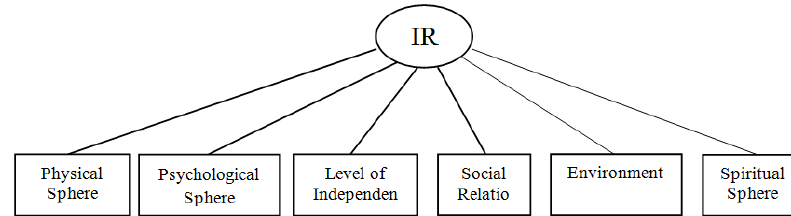
Figure 5. Correlation relationships of the indicator “IR” of the teachers’ group 2 Note: correlation at a significance level of